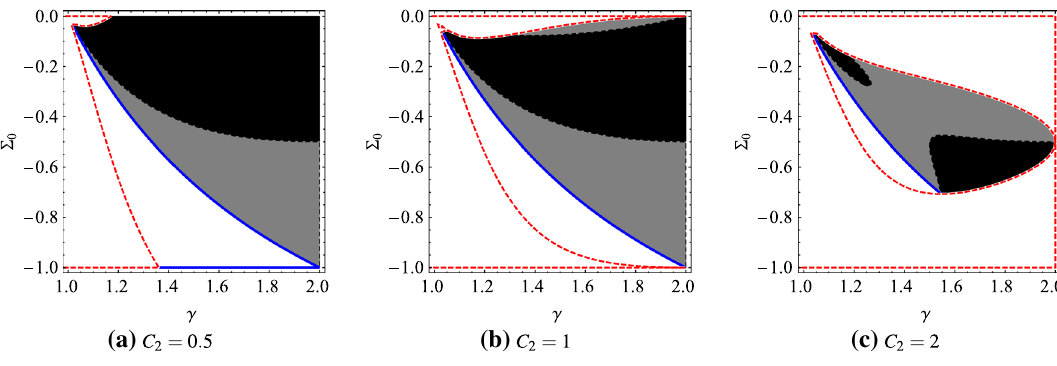
−√ γ − 1 ,Σ 0 denote the